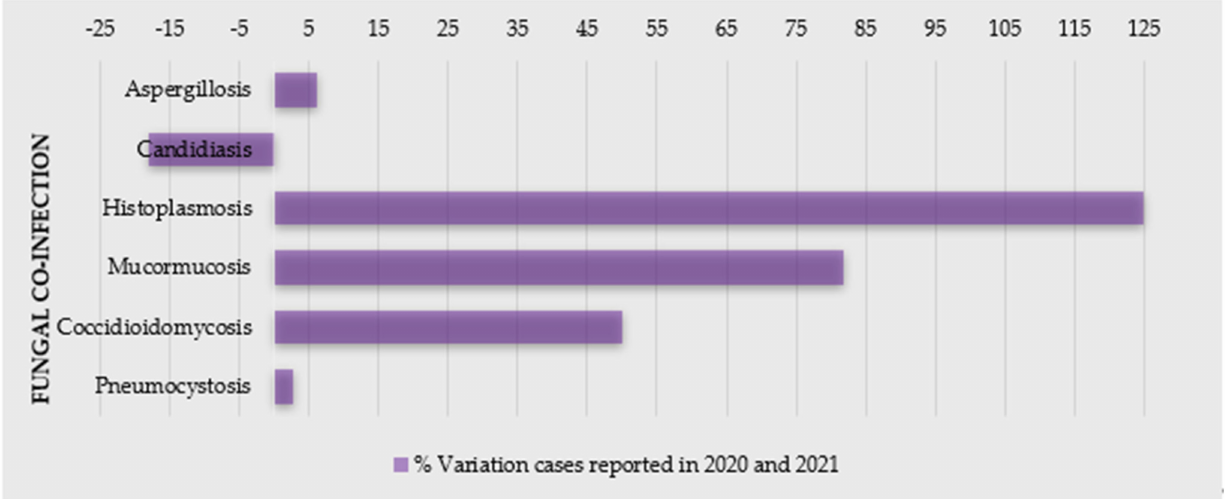
Figure 1. Percentage of variation of cases of COVID-19 patients with fungal co-infections reported in 2020 and 2021 (source: